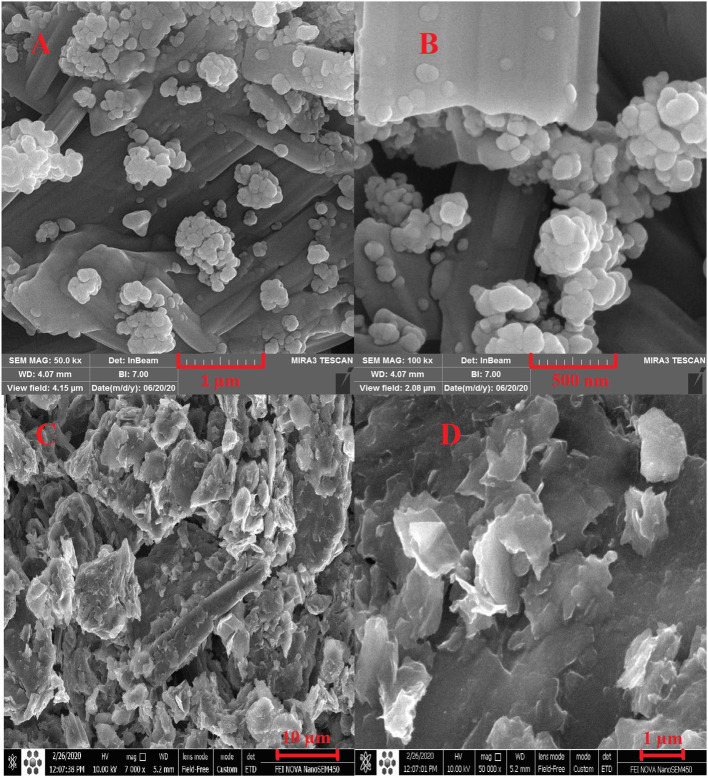
The SEM images of magnetic CdO nanoparticles (A,B) and carbon paste with magnetic CdO (C,D).